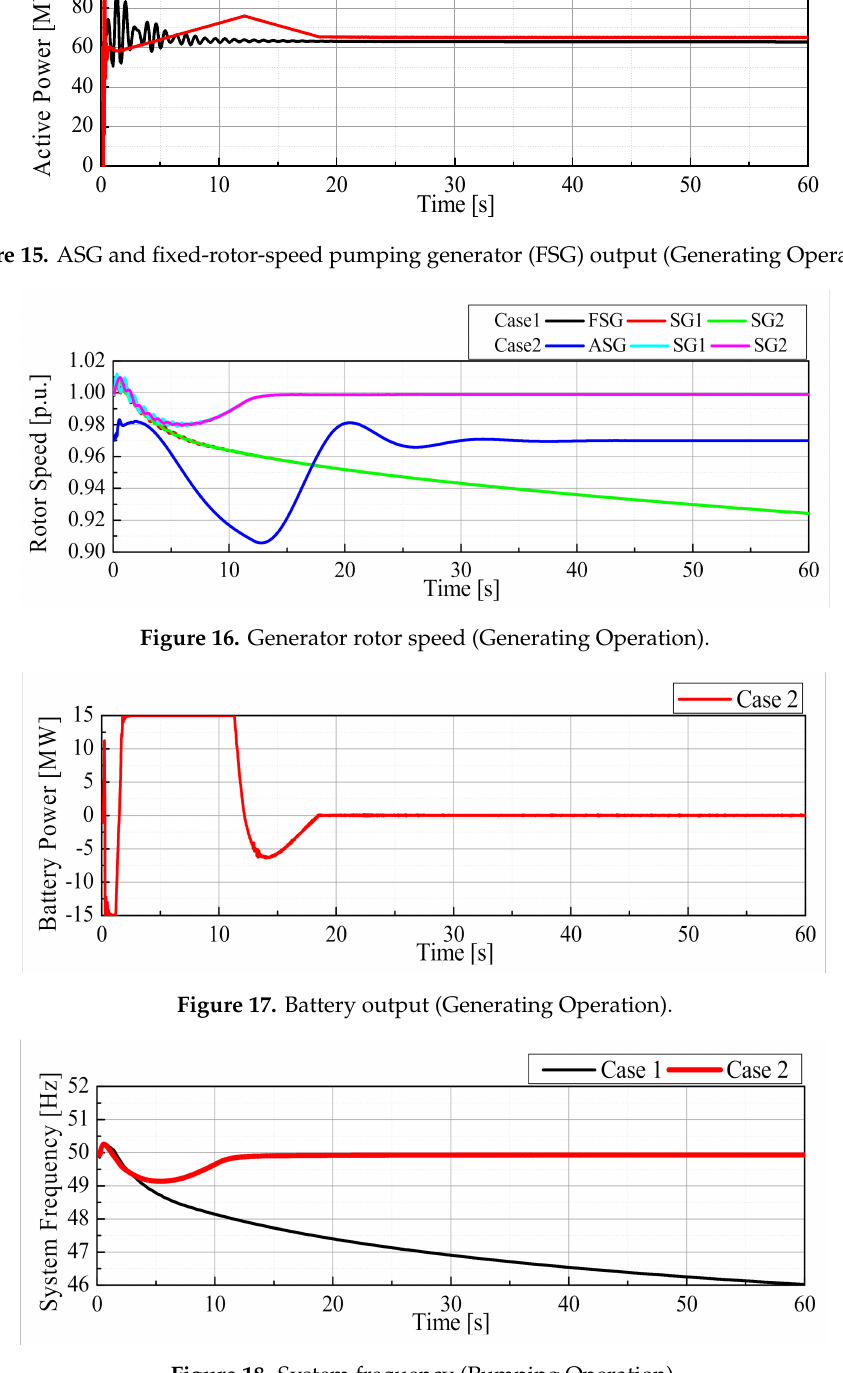
Figure 18. System frequency (Pumping